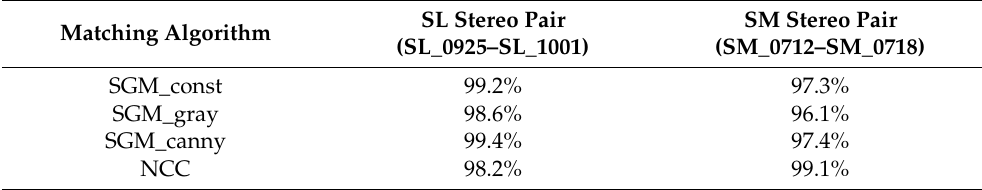
Table 4. Completeness of stereo matching